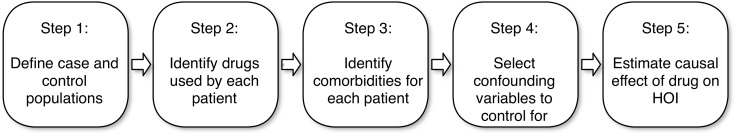
Illustration of the five steps of our analysis workflow.